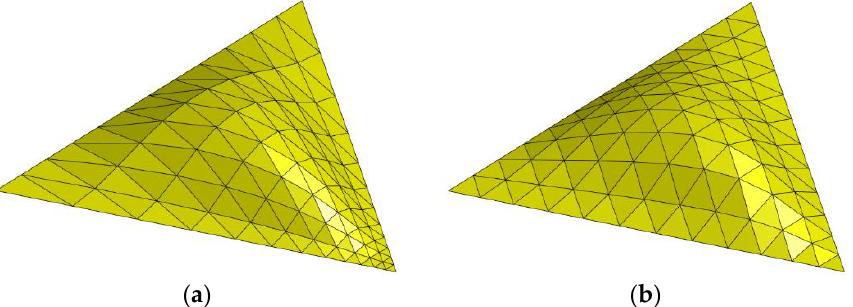
Figure 3. Equiareal parameterization with α = 0.38 and β = 1.00. ( a ) Original surface with e = 11.25. ( b ) Resultant surface with e ( α , β ) = 7.94.